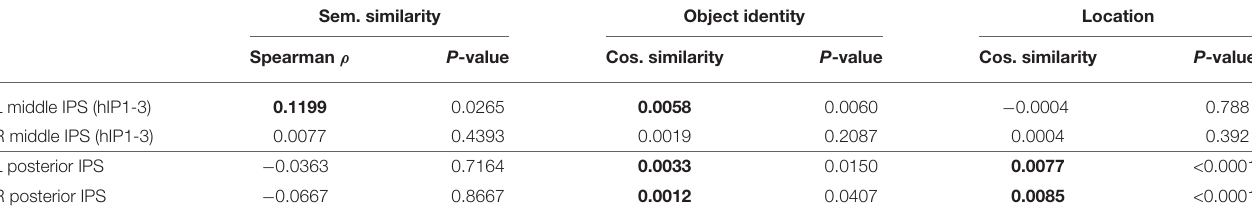
Column 2–3: Spearman correlations between the semantic similarity matrix and the fMRI similarity matrix. Columne 4–7: cosine similarity (CS) for location and object identity. Significant results at an uncorrected P < 0.05 are marked in bold. L, left; R, right.